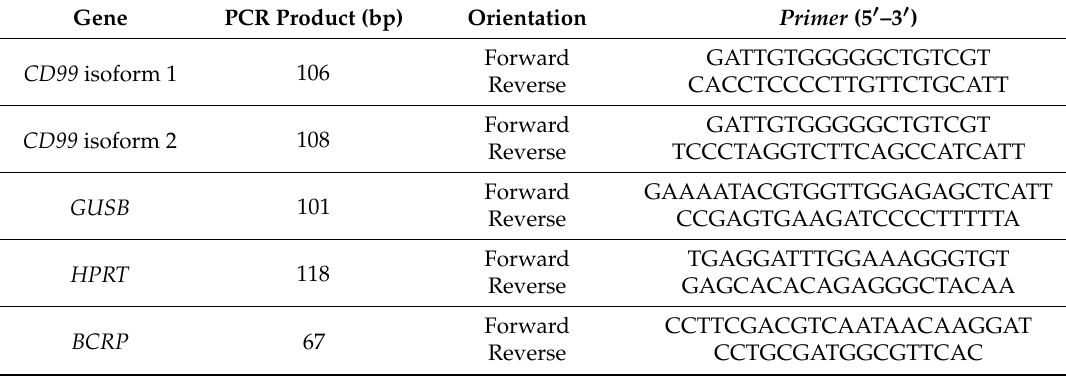
Table 1. PCR product size and sequence of primers for real time PCR. Gene PCR Product (bp)